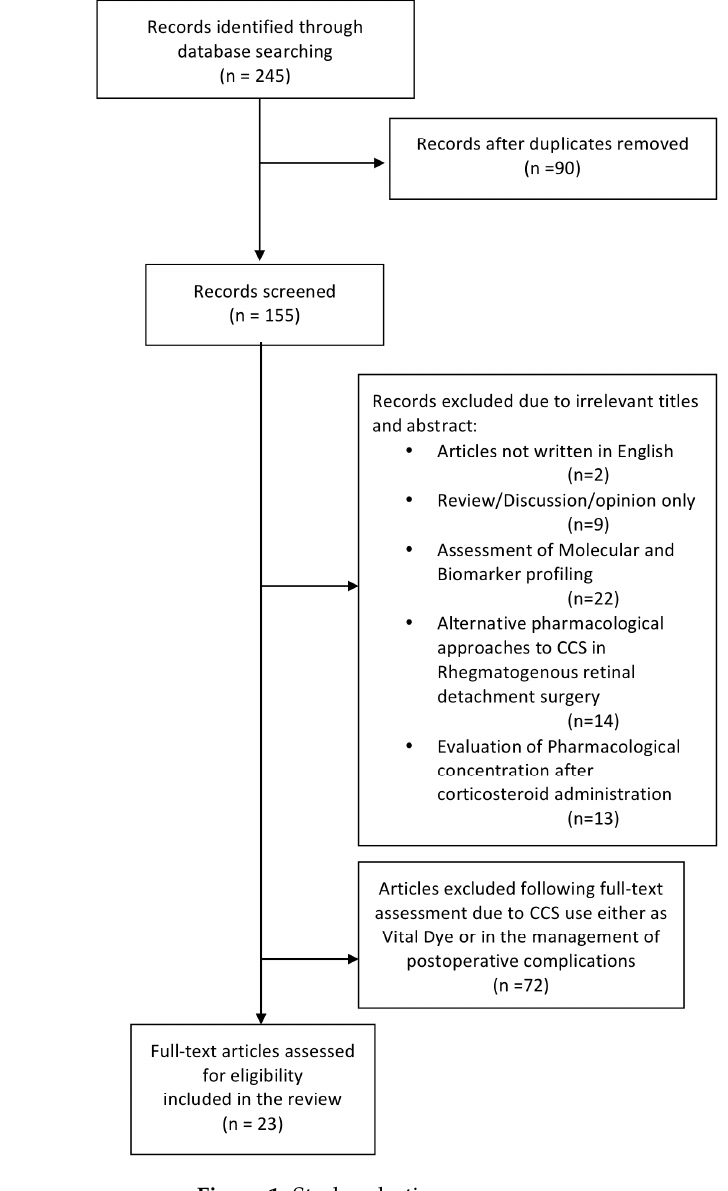
Figure 1. Study selection process.